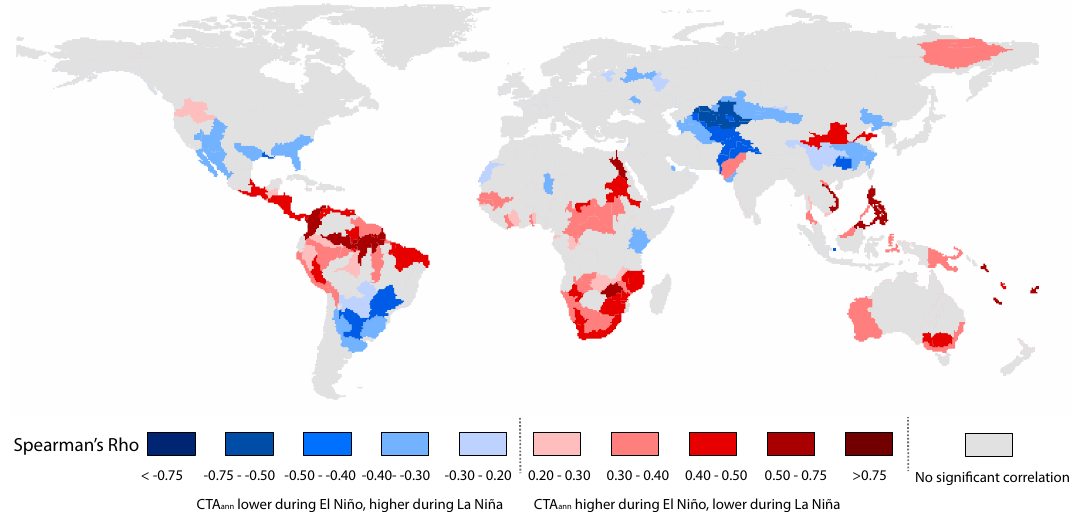
Figure 2. Correlation (Spearman’s Rho) of yearly water scarcity conditions (CTA ratio), as assessed under fixed socioeconomic conditions, to variations in JMA SST using the 3-monthly period with the highest correlation (JMA SST bestoff ). Significance was tested by regular bootstrapping ( n = 1000, p ≤ 0.05) and the correlation is only shown for those areas with significant correlations. Positive correlations indicate increases in CTA-ratio values (more severe water scarcity conditions) with the JMA SST bestoff index moving towards El Niño values. Negative correlations indicate decreases in CTA-ratio values (less severe water scarcity conditions) with the JMA SST bestoff index moving towards El Niño values.